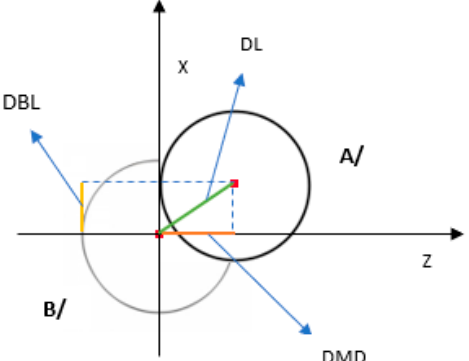
Figure 5. Axis deviations from an occlusal view between the planned and final implant position. A/ = actual implant position; B/ = planned implant position; BLD = bucco-lingual deviation; DL = lateral deviation; MDD = mesio-distal deviation.